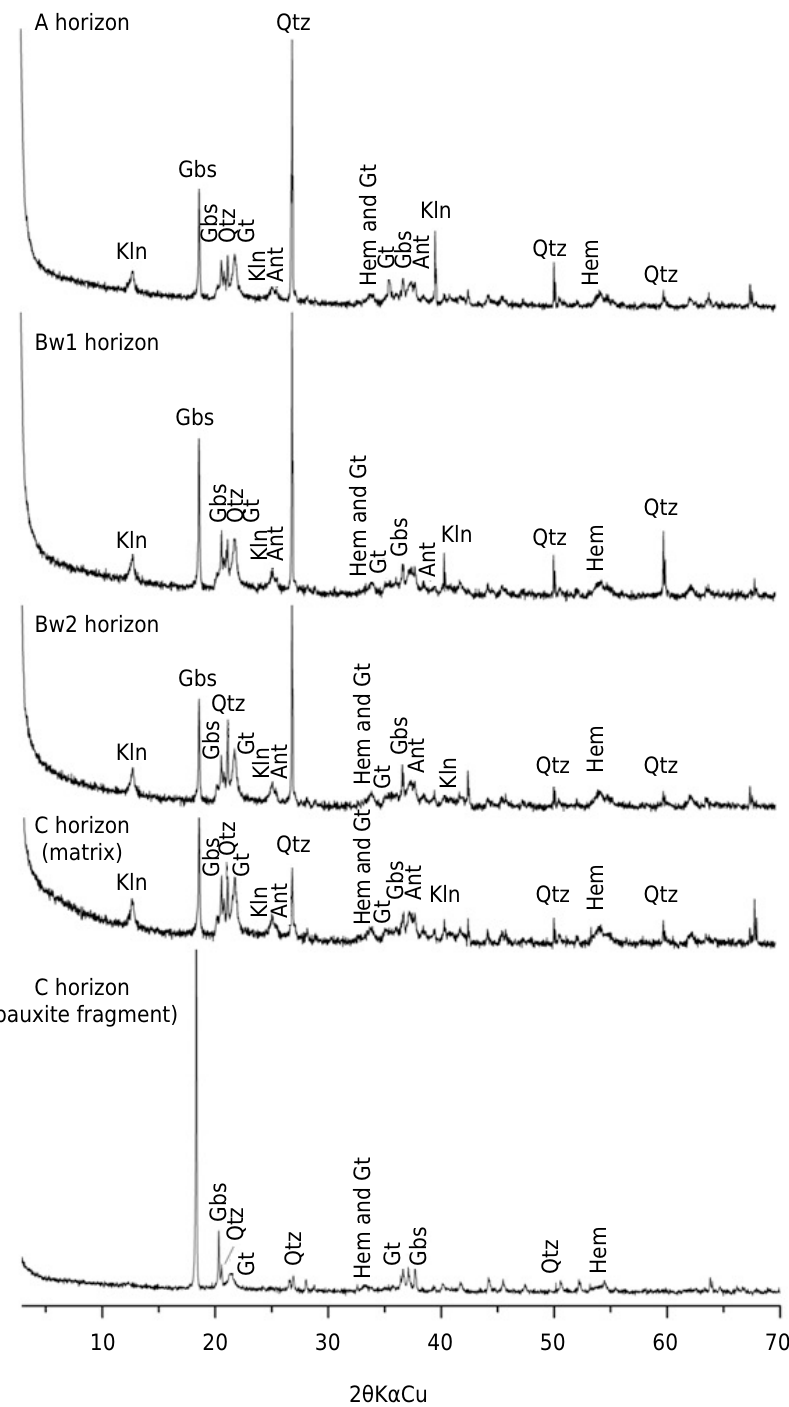
Figure 3. X-ray diffractograms, which show the mineralogical composition of the A, Bw, and C horizons and the bauxite fragments in the C